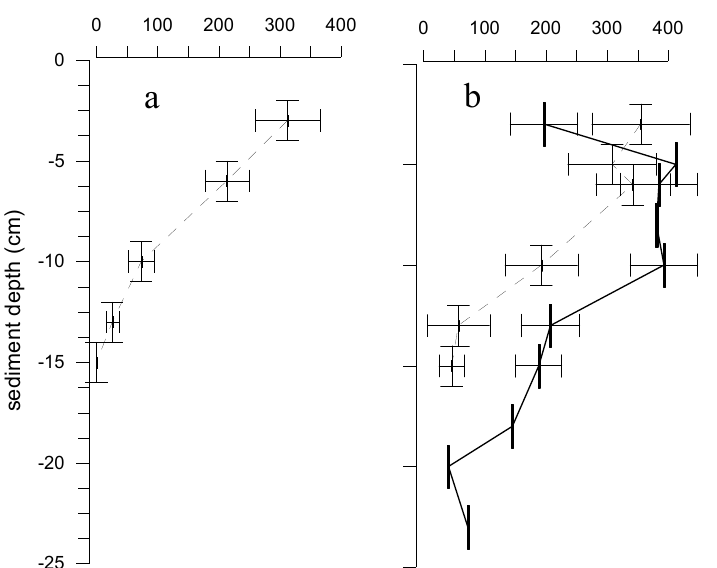
Figure 6. Vertical distribution of macrofauna burrow volumes (vertical bars: depth range; horizontal bars: standard errors) in the soft-bottom habitats occupied by community of chironomids (1700 ± 1300 ind m − 2 , n = 21) and oligochaetes (950 ± 900 ind m − 2 , n = 21) ( a ) before and ( b ) after invasion of M. neglecta (300 ± 180 ind m − 2 , n = 13). Dashed lines denote burrow volumes of chironomids and oligochaetes, solid line — burrow volumes of M. neglecta . Modified after [77].